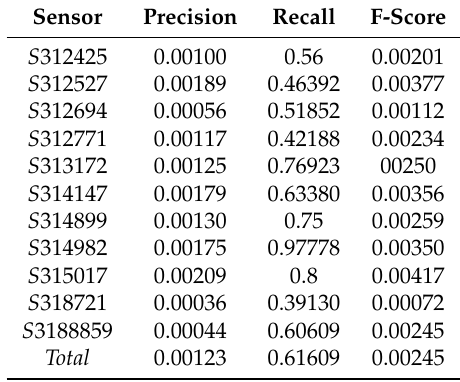
Table 9. Quality of fit for the Phase 1-Test data using standard normal